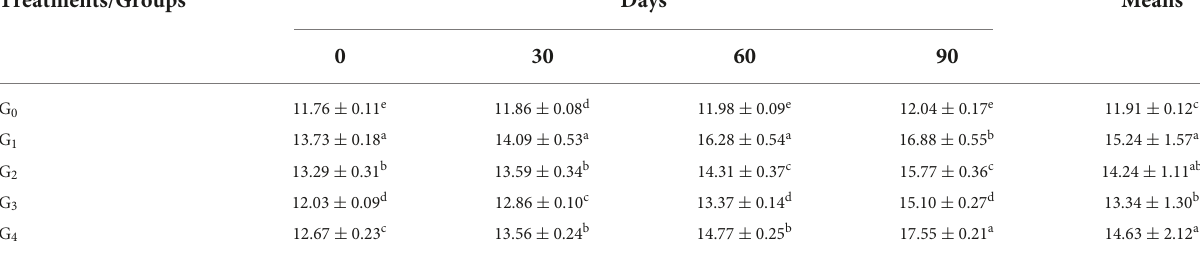
Means carrying the same letters in a column are not significantly different. G 0 = Control Group (no prebiotic given), G 1 = 963 mg/kg Inulin + 10 ppm NaFeEDTA, G 2 = 963 mg/kg Inulin+20ppmNaFeEDTA,G 3 =963mg/kgGOS+15ppmFeSO 4 ,G 4 =963mg/kgGOS+30ppmFeSO 4